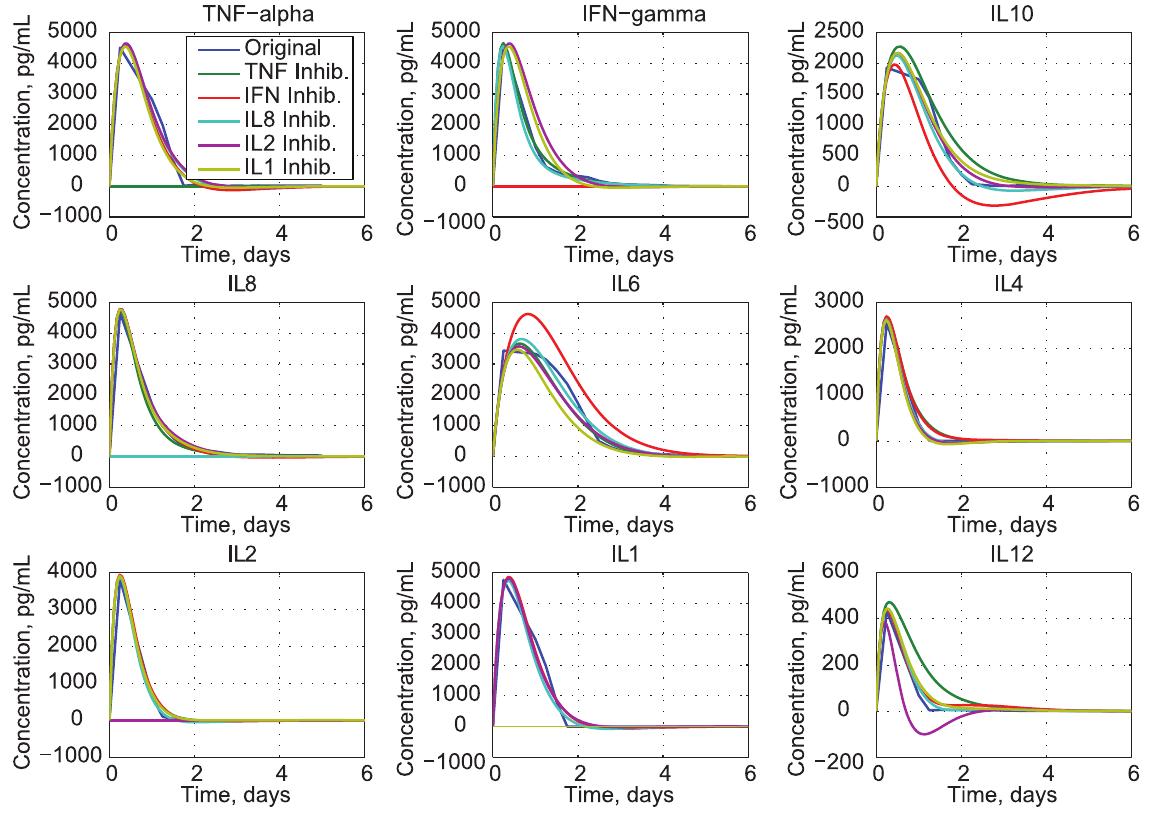
Figure 10. Effects of inhibiting pro-inflammatory cytokines.